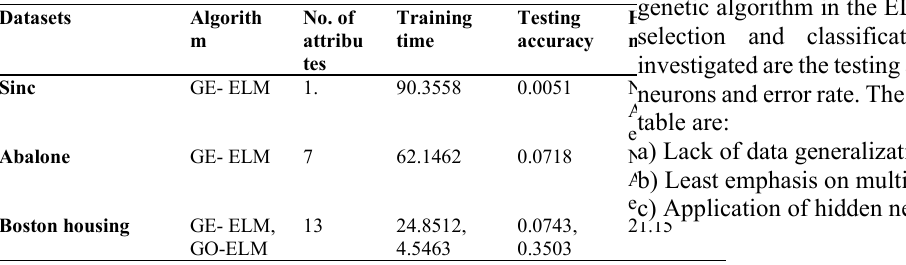
a) Lack of data generalization b) Least emphasis on multi-objective formulation c) Application of hidden